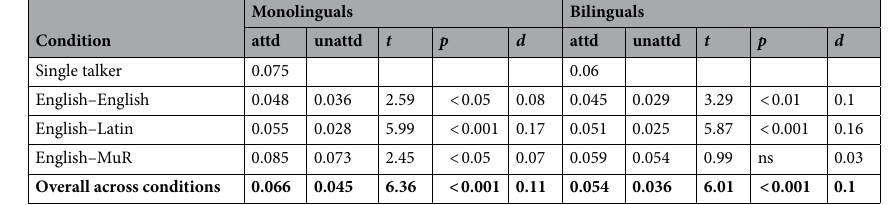
Table 3. Reconstruction accuracy scores (r) by condition and group. attd attended stream, unattd unattended